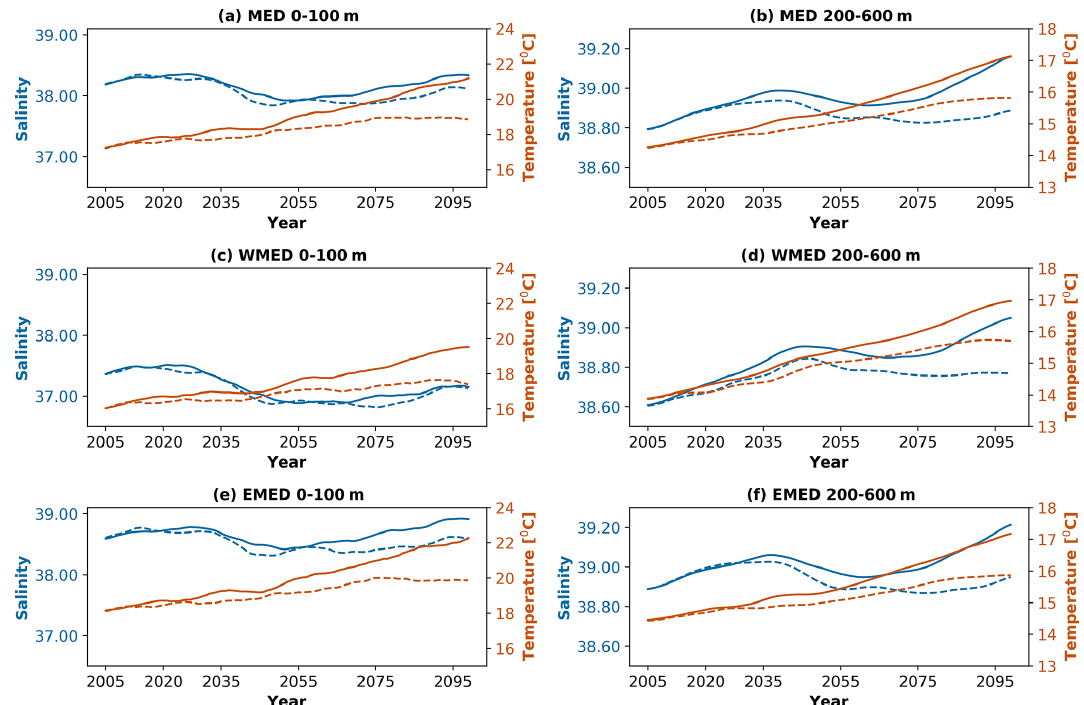
Figure 3. Yearly time series for the period 2005–2099 of salinity (blue) and temperature (dark orange, in ◦ C) under the emission scenarios RCP8.5 (solid lines) and RCP4.5 (dashed lines) in the Mediterranean Sea (MED, a–b ), Western Mediterranean (WMED, c–d ) and Eastern Mediterranean (EMED, e–f ) for the 0–100m (a, c, e) and 200–600m (b, d, f) layers. The yearly time series have been smoothed using the 10-year running